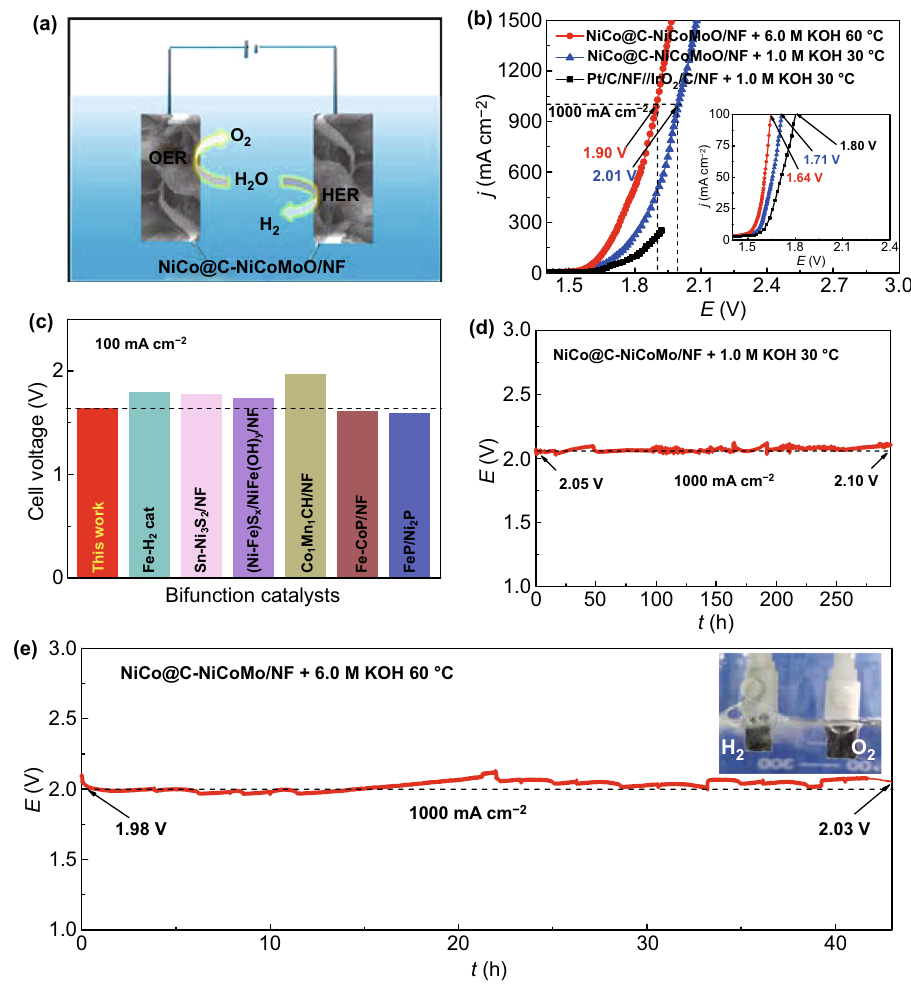
Fig. 6 a Using NiCo@C-NiCoMoO/NF as the cathode and anode for water electrolysis. b LSV curves of OER for the investigated samples. c Comparison WE potentials for this work and reported catalysts [8, 47, 51, 53, 55, 57]. d , e CP curves of NiCo@C-NiCoMoO/NF under 1.0 M KOH + 30 °C and 6.0 M KOH + 60